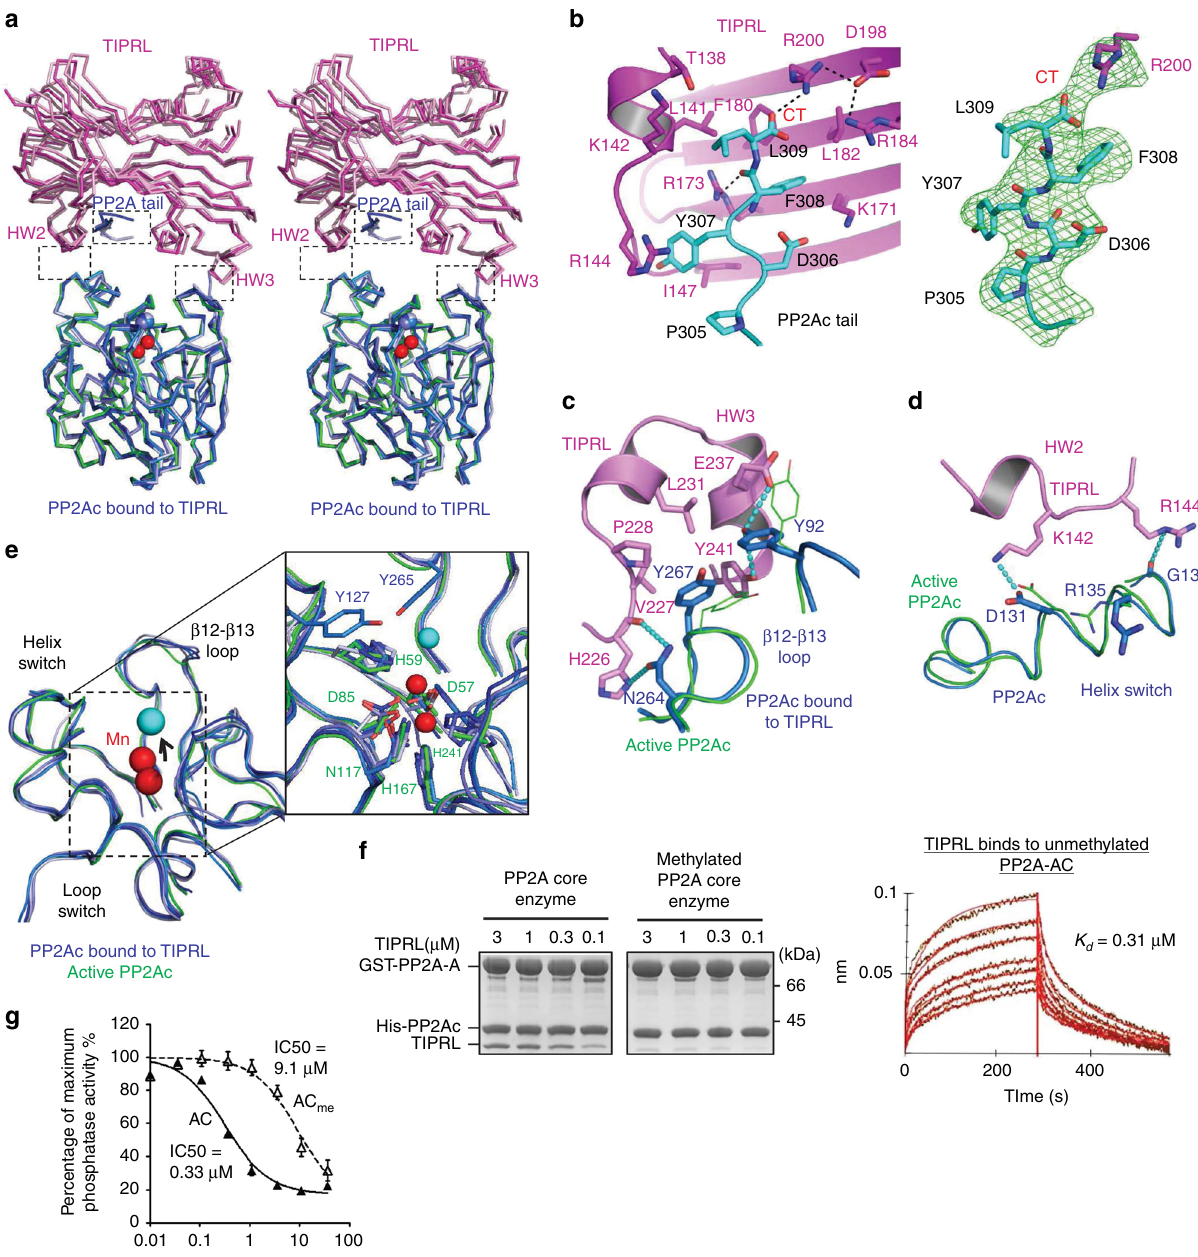
Fig. 2 Interactions between PP2Ac and TIPRL. a An overview of the interactions between PP2Ac (blue) and TIPRL (magenta) shown in ribbon with dashed boxes highlighting three separate interaction interfaces. Four copies of the complex in the asymmetric unit are overlaid. Manganese ions in active and TIPRL-bound PP2Ac are in red and blue spheres, respectively. b A close-up view of the interaction between PP2Ac tail (cyan) and TIPRL (left). The F O – F C omit map for PP2Ac tail and the side chain of R200 of TIPRL is contoured at 3.0 σ in green mesh (right). CT stands for C-terminus of PP2Ac. H-bond interactions are shown in black dashed lines. c , d Interaction interfaces of HW3 and HW2 of TIPRL with the structural elements near the active site of PP2Ac shown in cartoon, overlaid with active PP2Ac as in a . The color scheme is the same as in a . Residues in the TIPRL – PP2Ac complex are shown in sticks and those in active PP2Ac in lines. H-bond interactions are shown in cyan dashed lines. e Structural comparison of active sites of the active (green) vs TIPRL-bound (blue) PP2Ac, with manganese ions in red and cyan spheres, respectively. The right box shows the close-up view of the chelation of manganese for active and TIPRL-bound PP2Ac. Key residues involving in chelation are labeled in green and blue for active and TIPRL-bound PP2Ac, respectively. f Pull-down of titrated concentrations of TIPRL by non-methylated (left) vs methylated (middle) PP2A core enzyme containing the GST- tagged scaffold subunit (PP2A-A). The bound proteins were examined on SDS-PAGE. Association and dissociation curves of TIPRL to BLI surface activated by GST-tagged unmethylated PP2A core enzyme with calculated binding af fi nity (right). g Phosphatase activity of PP2A core enzyme in the presence and absence of increasing concentrations of TIPRL, normalized in percentage to the activity in the absence of TIPRL. Experiments were performed in triplicate and repeated three times. Data are shown as mean and standard error of the mean